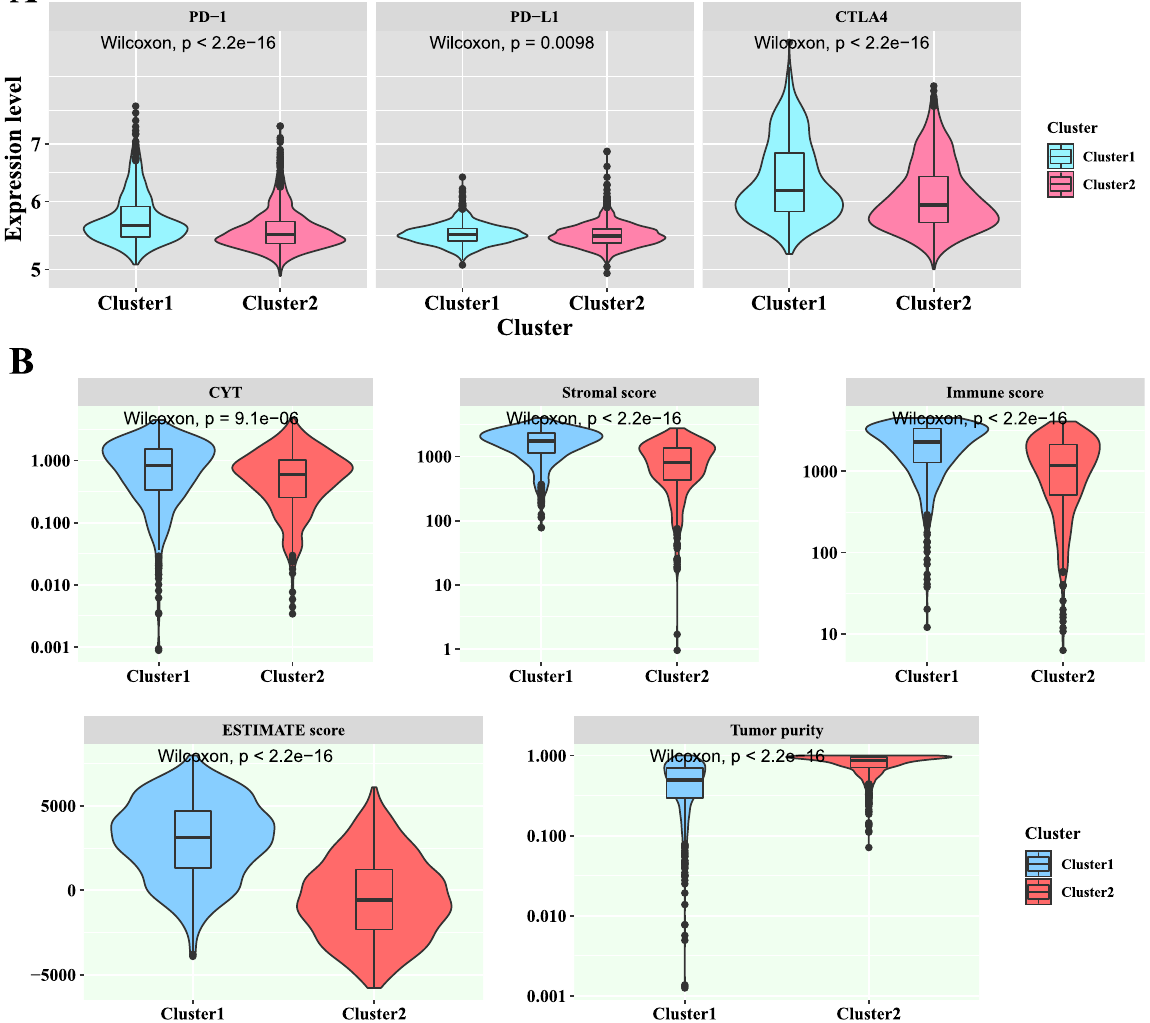
Figure 5. The violin plots of three immune checkpoints and five immune related indices between two clusters. ( A ) The violin plots of the PD-1, PD-L1 and CTLA4 expression levels for two clusters. (B) The violin plots of the CYT, stromal score, immune score, ESTIMATE score and tumor purity for two